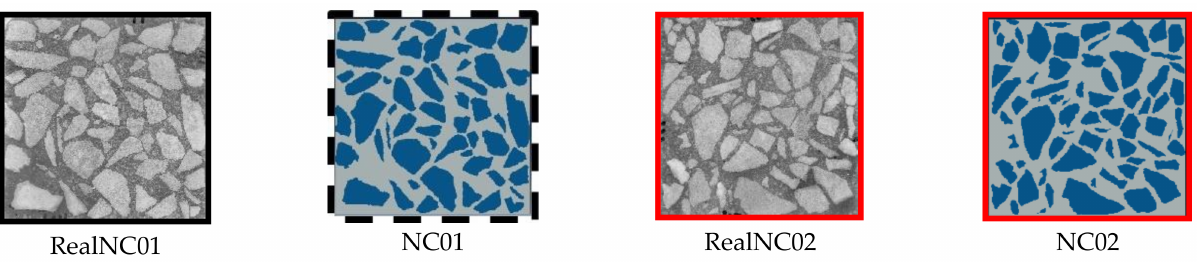
Figure 4. Real images and corresponding